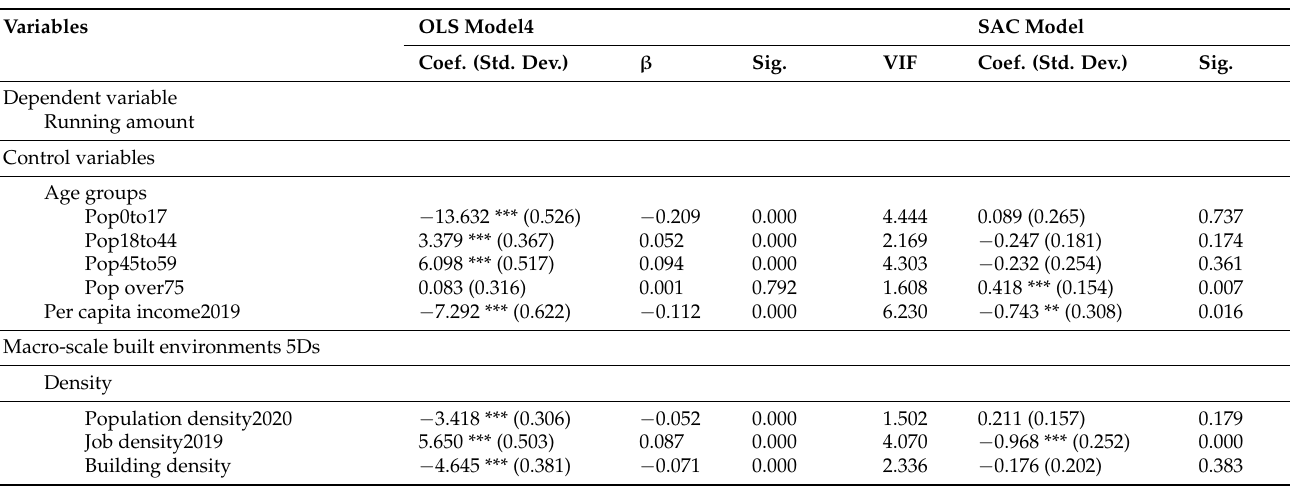
Figure 9. The results of Moran’s I test. ( a ) The spatial autocorrelation of residual error of the OLS model (100 m buffer); ( b ) the counterpart of residual error of the SAC model (100 m buffer). Table 4. The ordinary least squares results (OLS) and spatial regression results (SAC).